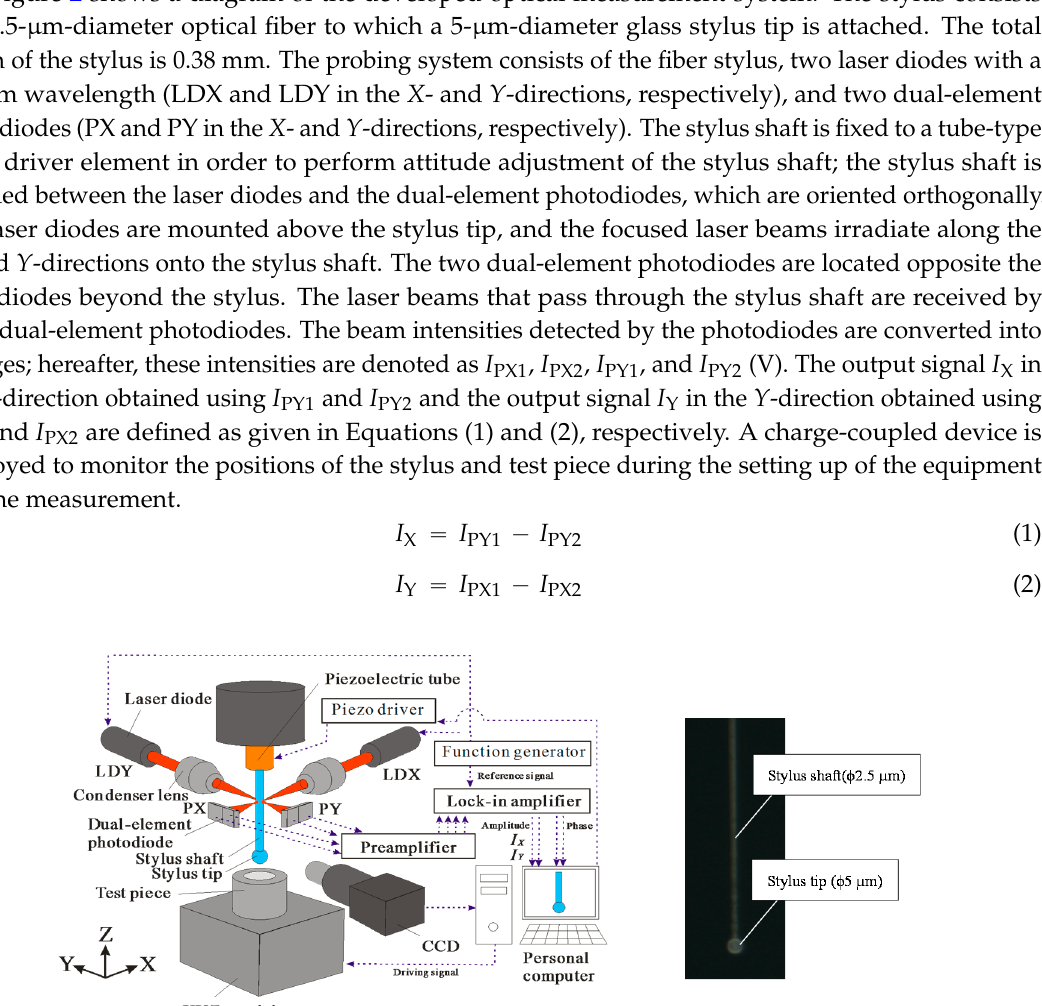
Figure 3. Principle of measurement. ( a ) initial stage, ( b ) displacement in X ‐ direction, and ( c ) displacement in Y ‐ direction.